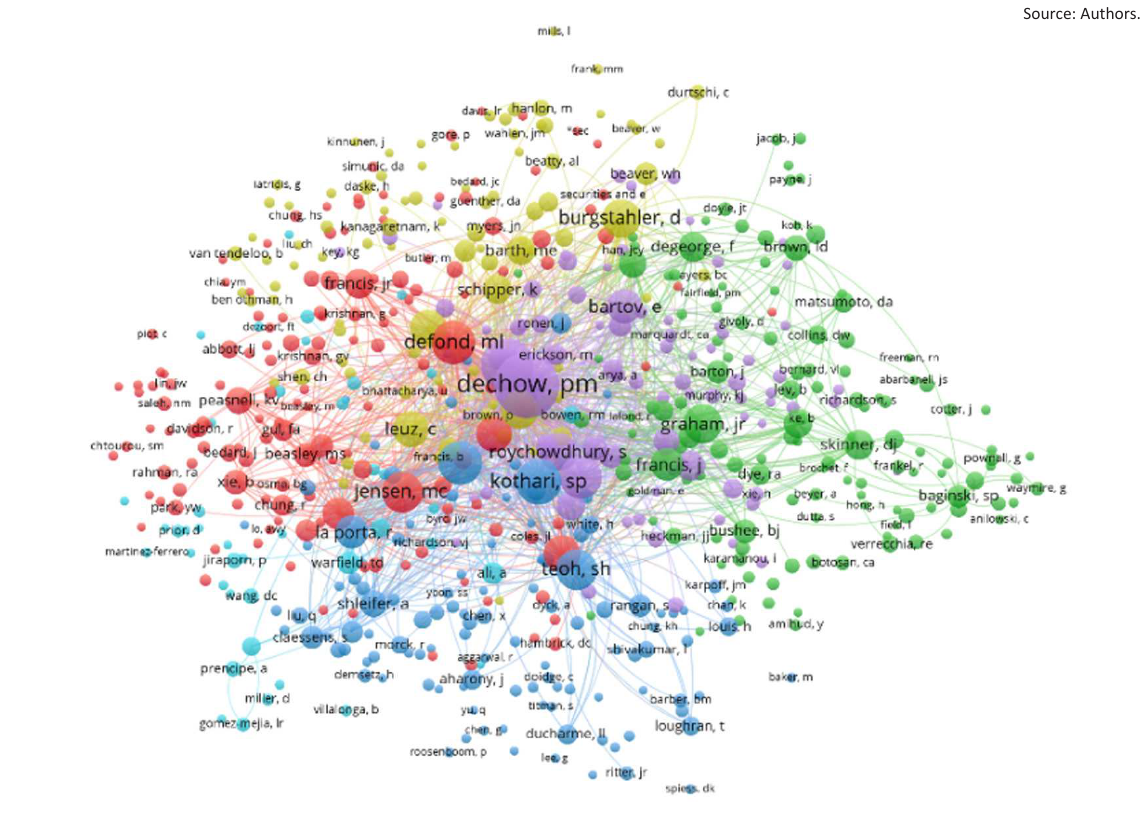
Figure 5. Co-citation analysis – cited authors from 1900 to